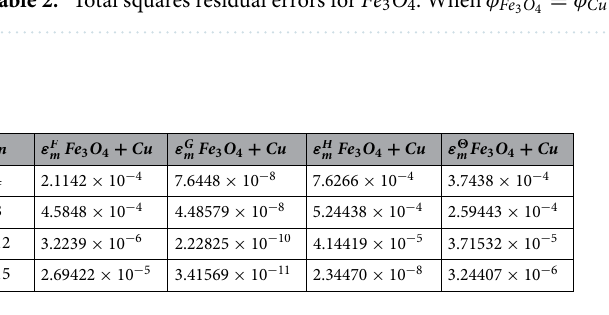
Table 3. Total squares residual errors for MWCNTs. φ Fe 3 O 4 = φ Cu = 0.02, Pr = 6.2, Re ω = 0.3, Re � = 0.13.